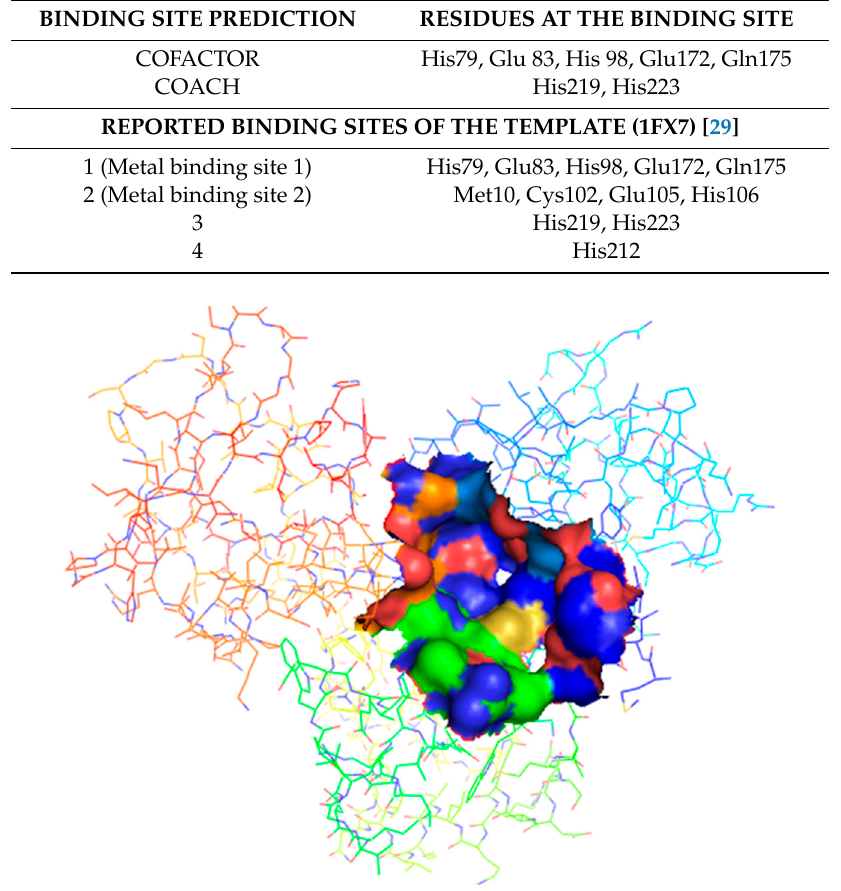
Figure 3. Metal Binding site 2 of the IdeR model. Binding pocket has been shown in surface representation. The image was generated with PyMOL molecular visualization tool.